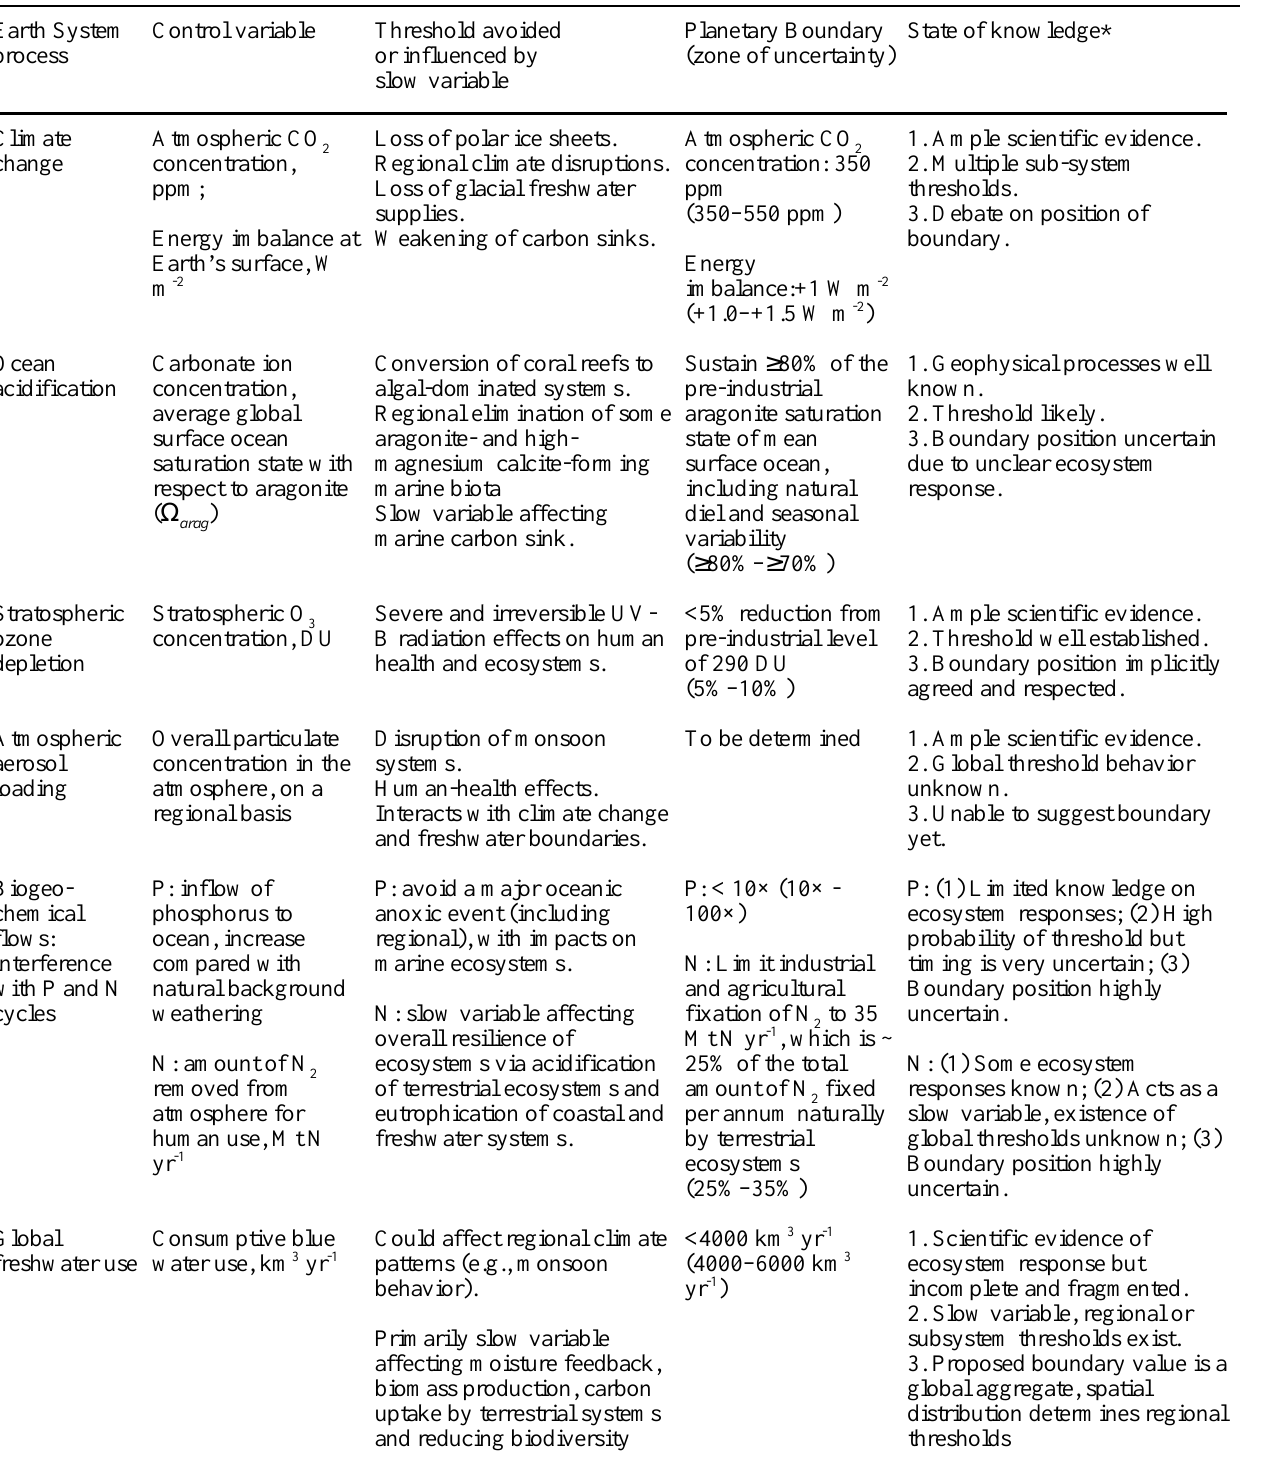
Table 1. Proposed planetary